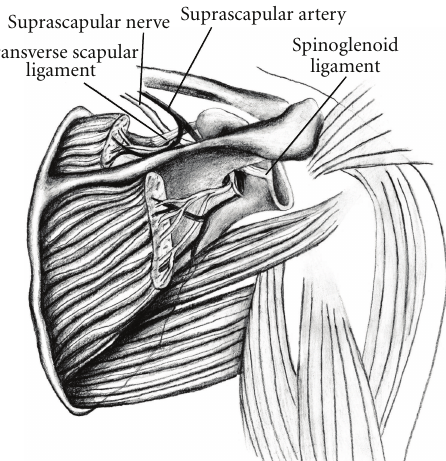
Figure 1: Illustration of suprascapular nerve anatomy. The nerve courses under the transverse scapular ligament and the spinoglenoid ligament with motor branches to the supraspinatus and infraspinatus. From Boykin et al., [50] permission granted.